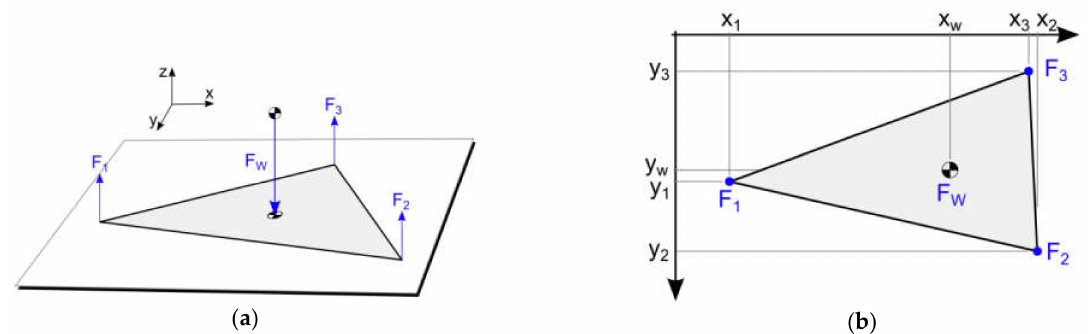
Figure 6. Forces in a 3-point suspension system: ( a ) 3D coordinate systems with X, Y and Z axes ( b ) 2D coordinate systems with X and Y